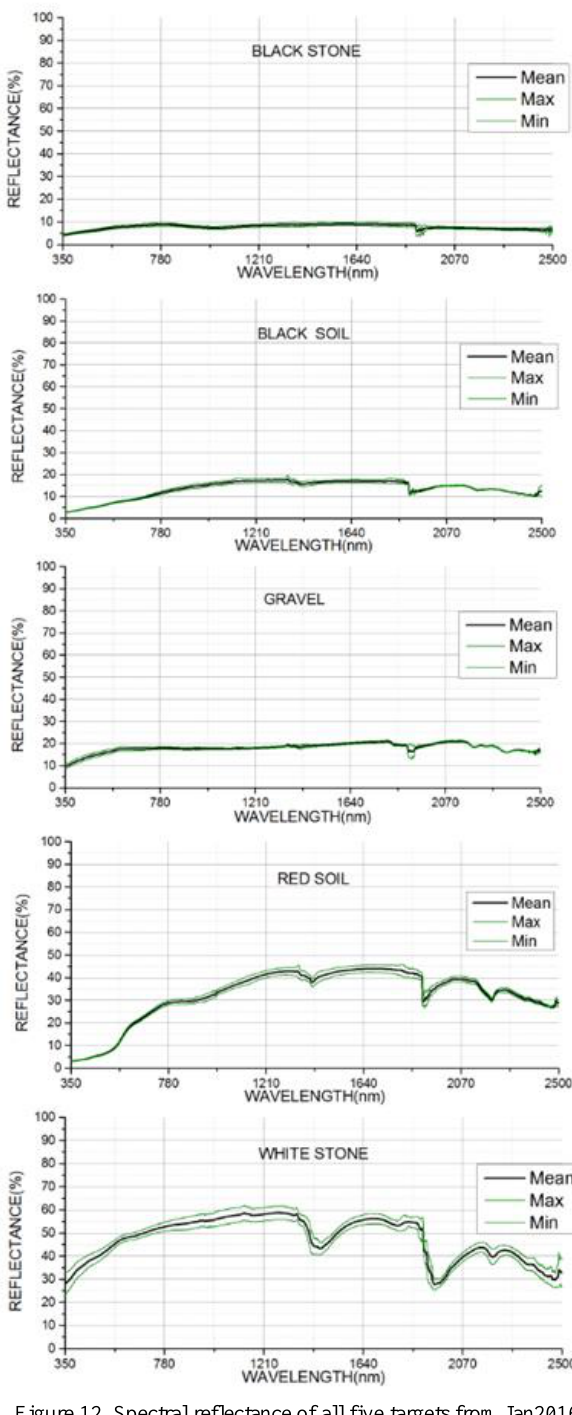
Figure 12. Spectral reflectance of all five targets from Jan2016 to